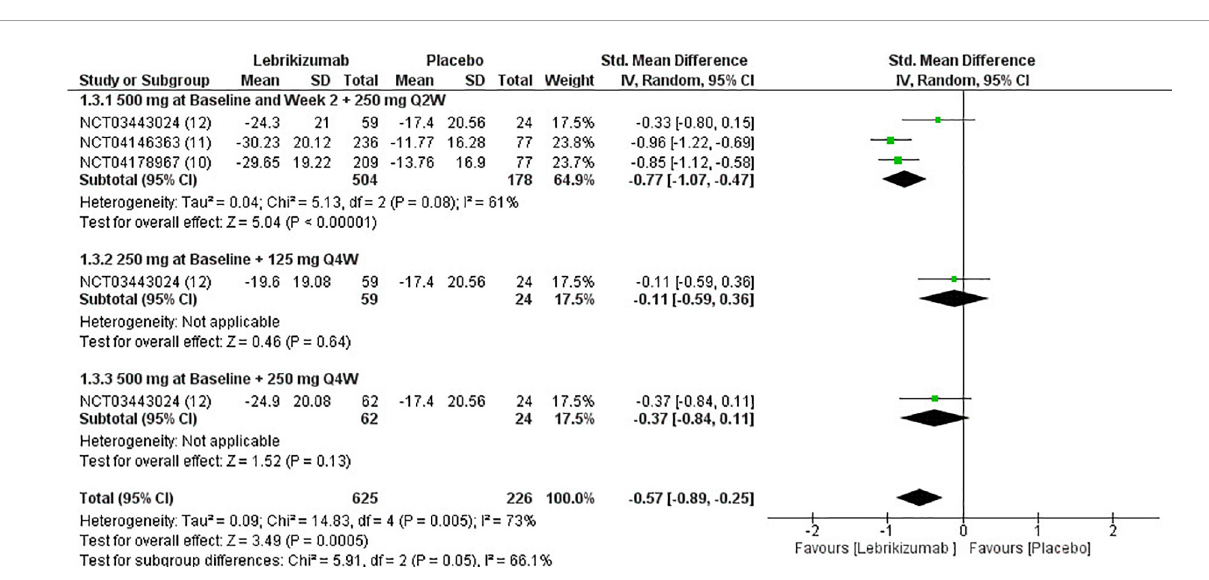
previous subgroups (RR = 0.13, 95% CI [0.01, 2.67], p = 0.19 I 2 =